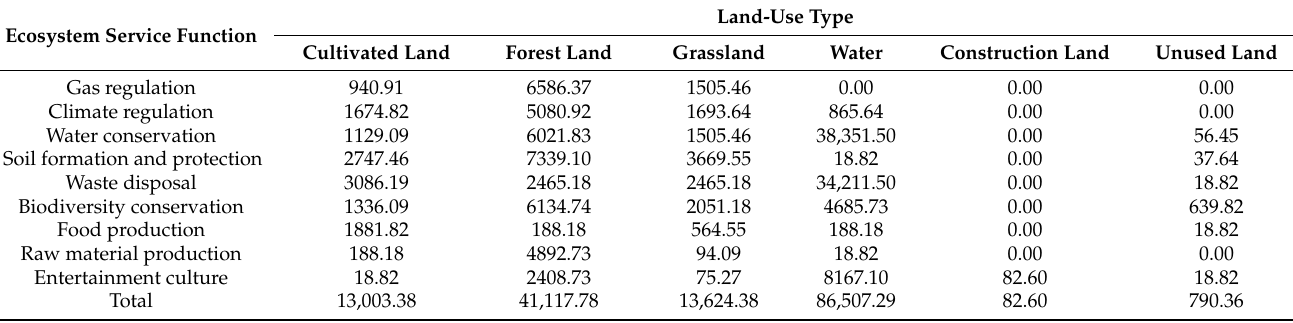
Table 2. Ecosystem service value coefficients in Xinjiang (yuan/hm 2